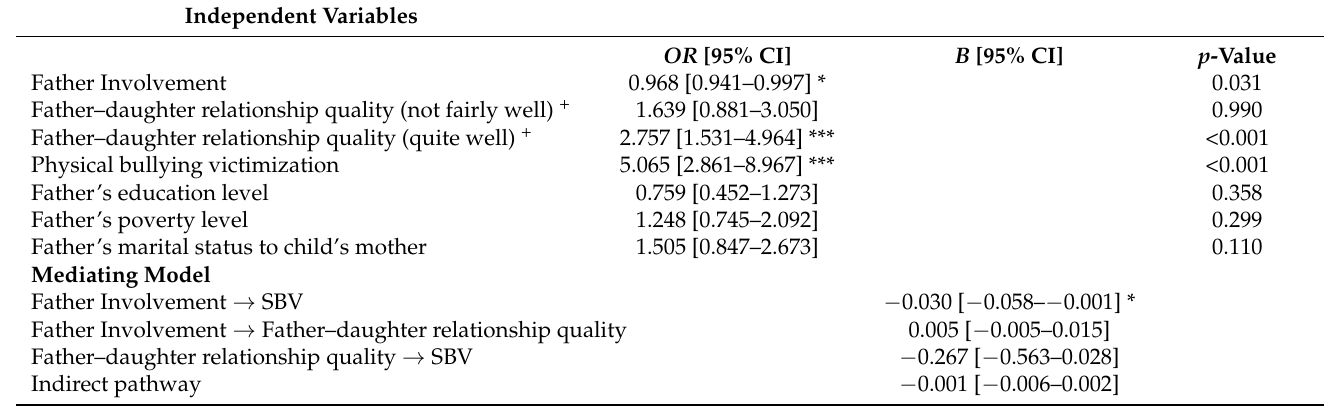
Table 3. Logistic Regression and Mediation Analysis of Father Involvement and Father–Child relationship on Child Social Bullying